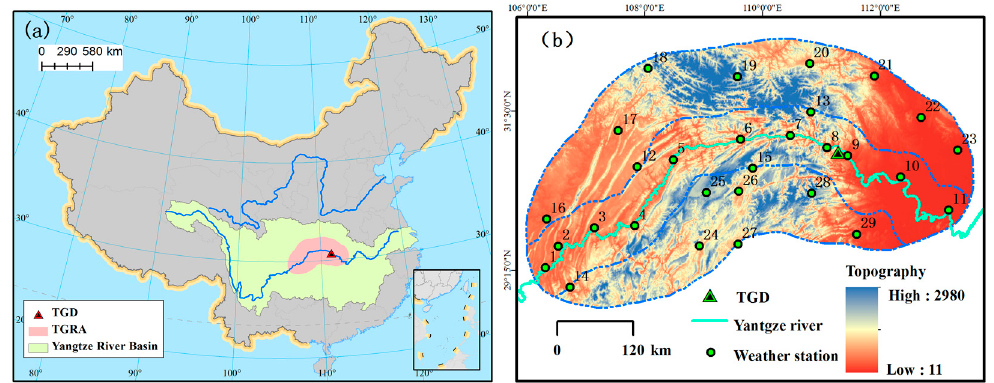
Figure 1. Location of the Three Gorges Reservoir area ( a ); the topography of Three Gorges Reservoir area and the location of weather stations ( b ). Further weather station information is provided in supplemental Table 1. Table 1. Extreme climate indices used in this study.